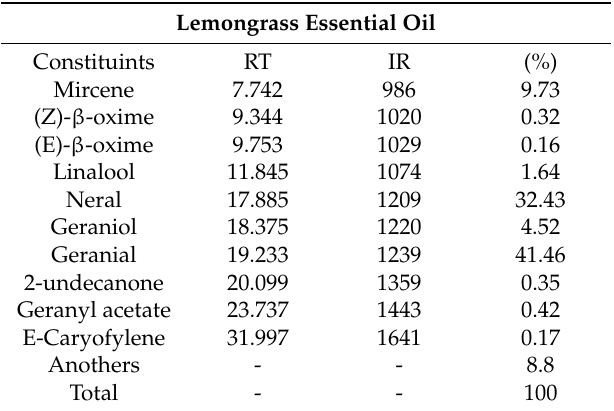
Table 2. Chemical components of the Cymbopogon citratus essential oil identified by mass spectrometry (CG/MS) and its respective levels expressed in percentage.